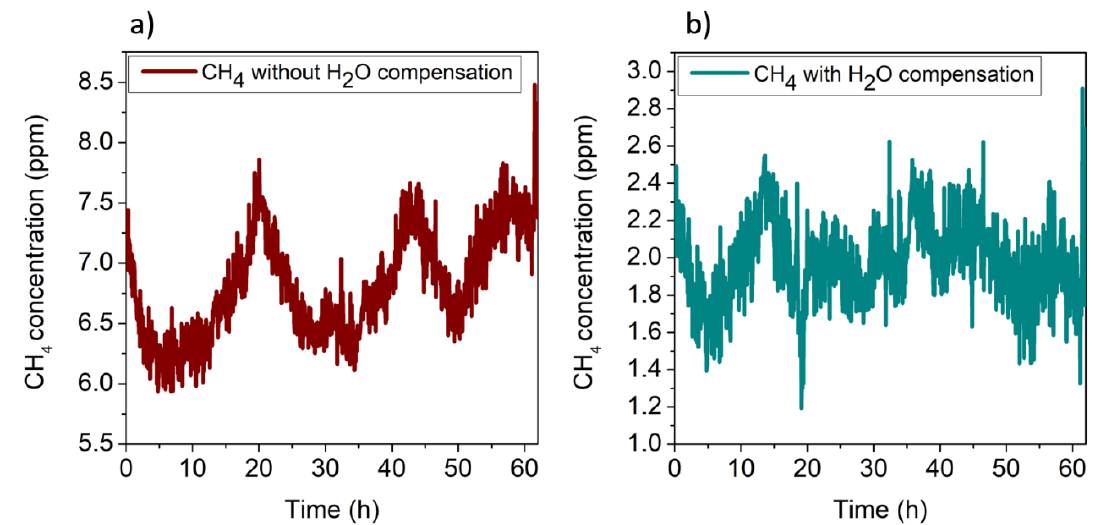
Figure 8. ( a ) QEPAS signal of methane in air without water compensation; ( b ) methane QEPAS signal after water compensation using the absolute humidity recorded by the hygrometer.